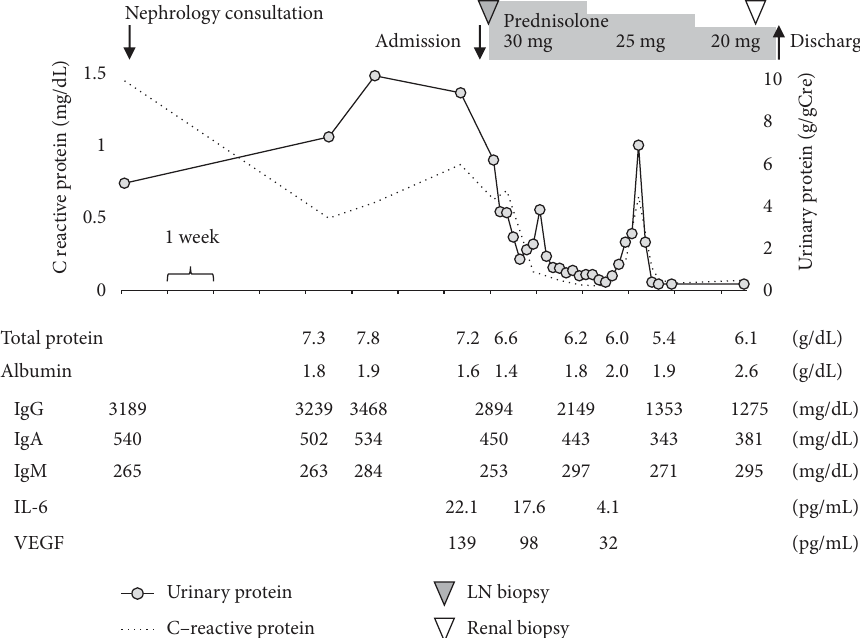
Figure 1: Clinical course of the patient. Te patient was referred to a nephrologist with a diagnosis of nephrotic syndrome at 76years of age. Te serum level of immunoglobulins was high in addition to massive urinary protein, and polyclonal gammopathy was identifed. Before administration of prednisolone for the treatment of nephrotic syndrome, inguinal lymph node biopsy was performed. Nephrotic syndrome promptly responded to prednisolone and proteinuria improved along with decreased disease markers of Castleman’s disease, such as IgG, IgA, C-reactive protein, serum IL-6, and plasma VEGF. During tapering of prednisolone, proteinuria transiently elevated. We performed renal biopsy to evaluate activity of renal involvement for decision making regarding long-term treatment. LN, lymph node; Ig, immu- noglobulin; IL-6, interleukin-6; and VEGF, vascular endothelial growth